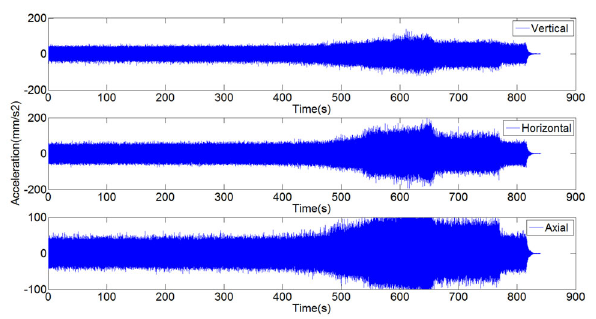
Fig. 6 Oblique cutting signal in spur gear transmission